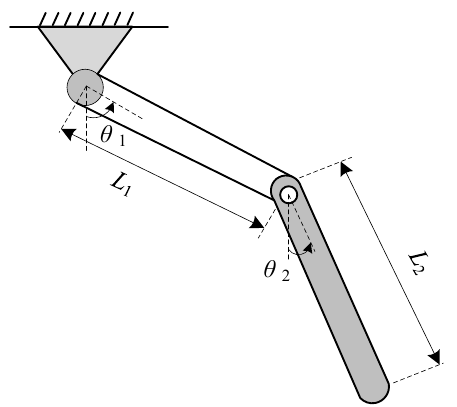
Figure 11. Schematic of the double pendulum.